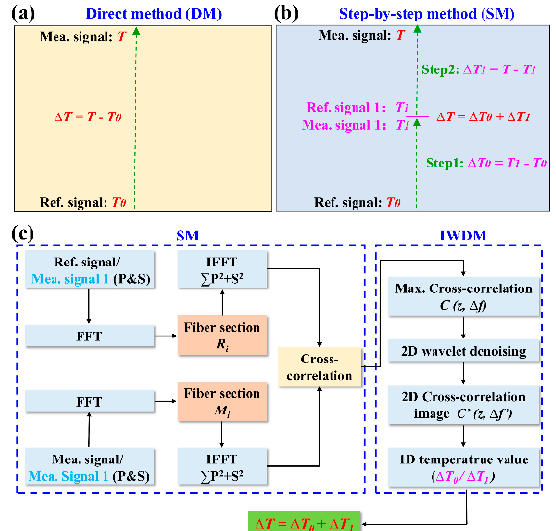
Figure 2. Schematic diagram of ( a ) direct method (DM) and ( b ) step-by-step method (SM); ( c ) flow dia- gram of temperature data processing by use of the SM and image wavelet denoising method (IWDM). Ref. signal: reference signal; Mea. signal: measurement signal; FFT: fast Fourier transformation; IFFT: inverse FFT; 2D: two-dimensional; 1D: